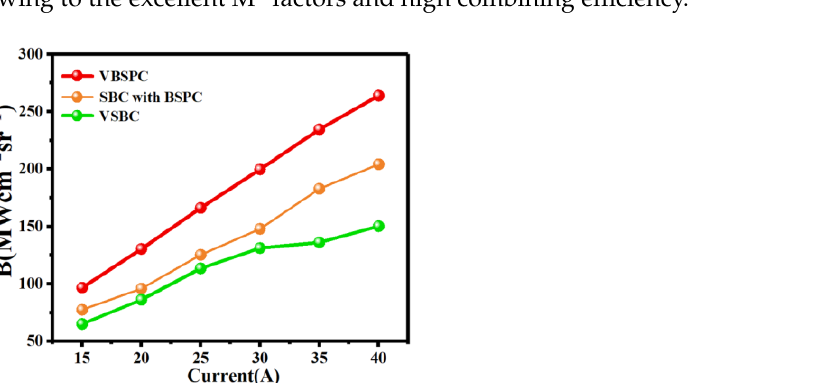
Figure 6. The wavelength of VBSPC at 40 A. 4. Discussion In summary, a beam combination technique to improve the brightness of diode lasers based on both V-shaped external cavity spectral beam combining and beam-waist split- ting polarization combining was proposed and demonstrated. The VBSPC setup shows the high beam combining efficiency approaching that of SBC, good beam quality exceed- ing a single emitter, and high brightness. A commercial standard cm-bar was combined by this system. A 16.2 W laser with M 2 factors of 1.79 × 3.92 in the fast and slow axis was demonstrated at 40 A. The brightness of the combined laser is as high as 262 MW·cm −2 ·sr −1 , 136% higher than that of spectral beam combining without using beam-waist splitting polarization (110 MW·cm −2 ·sr −1 ) at 40 A. We believe that the VBSPC will make contribu- tions to beam combining techniques. 5. Patents C.Z.Tong, F.Y .Sun, Y.F.Zhao, S.L.Shu, L.J.Wang, “Spectral beam combined laser sys- tem and method” , US patent 10333265 C.Z.Tong, Y.F.Zhao, F.Y.Sun, S.L.Shu, L.Wang, S.C.Tian, L.J.Wang, “Laser beam combining system” , US patent 10,768,434. Author Contributions: Methodology, Y.Z.; validation, C.T. and Y.Z.; investigation, Y.Z. and L.W.; data curation, J.F.; writing — review and editing, Y.Z. and C.T.; supervision, C.T. and Z.W.; project